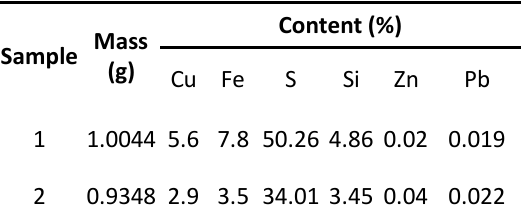
Table 4. Chemical composition of leaching residual for Sample 1 and Sample